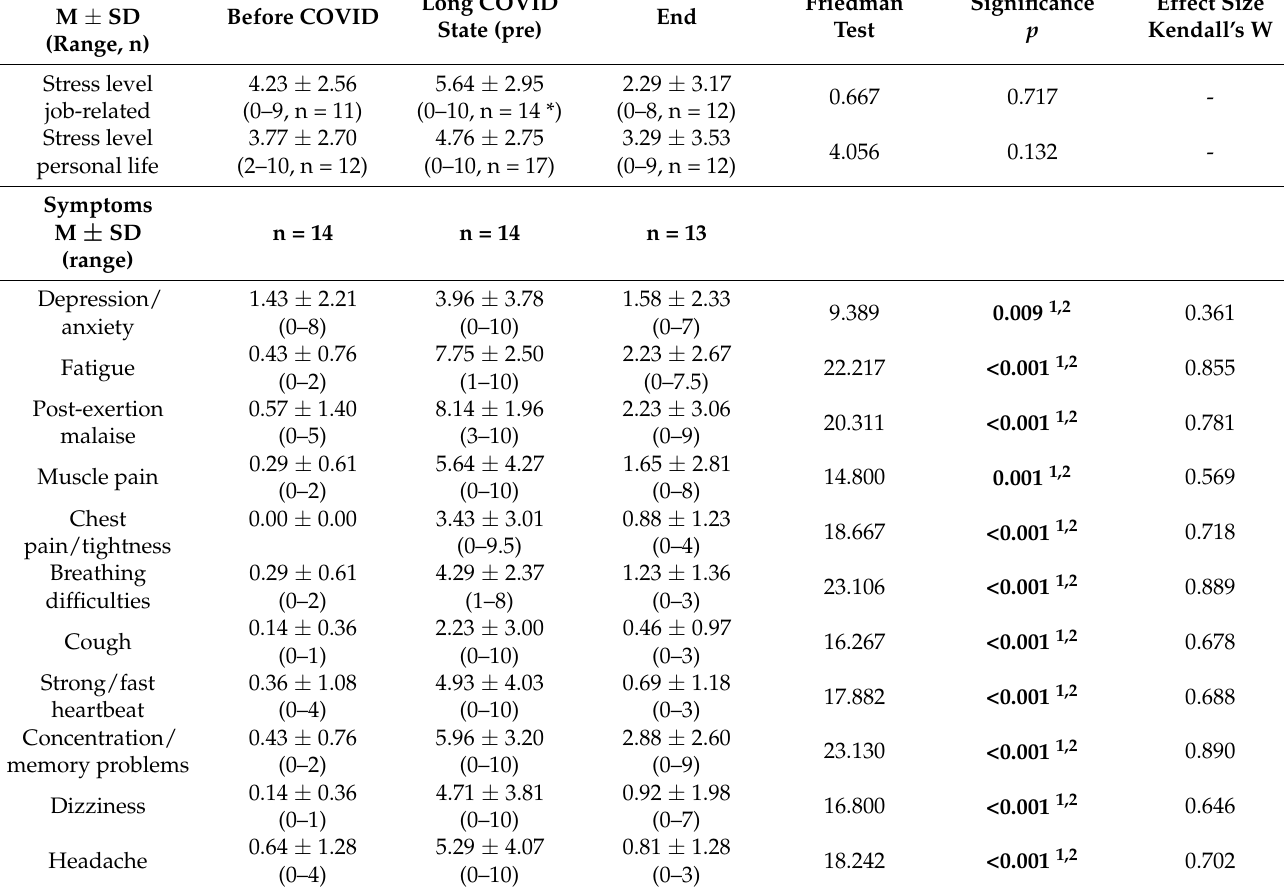
Table 3. Stress level and symptom intensity. Given are the arithmetic means, standard deviations (M ± SD) and range including the number of patients (n) for job-related and personal stress level, as well as for the intensity of the queried common long COVID symptoms (from 0 = no, 10 = very strong) for the different time points before COVID infection (retrospectively), during long COVID state (corresponds to pre) and at recovery/substantial heath improvement (end). The values of the Friedman test comparing the three time points, significance p and effect size Kendall’s W are given. The results of the pairwise comparisons are indicated in